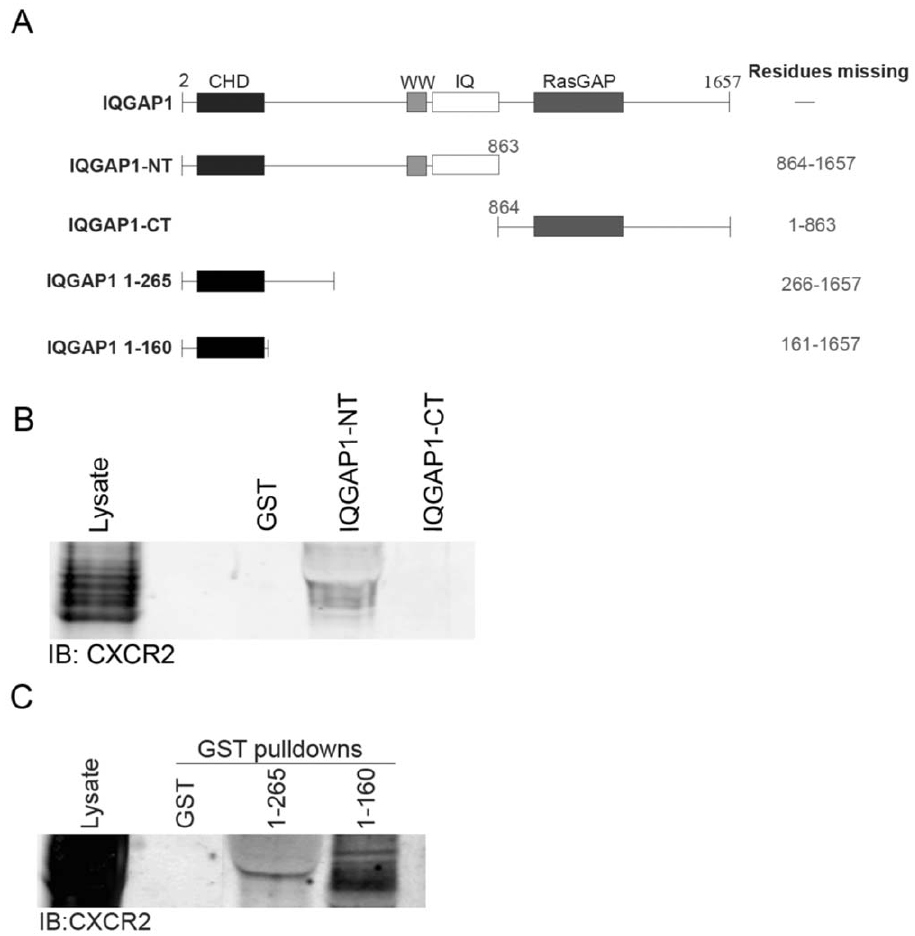
Figure 3. CXCR2 interacts with the amino-terminus of IQGAP1 specifically through amino acids 1–160. (A) Domains contained in the GST-IQGAP1 fusion construct. Western blot analysis with anti-CXCR2 antibody of differentiated HL-60 CXCR2 lysates (Input) and eluates from (B) GST, GST-IQGAP1-N-terminus (NT), and IQGAP1-C-terminus (CT) pull-down reactions and (C) GST, GST-IQGAP1-1-265, and -1-160. Data shown are representative of three separate experiments.